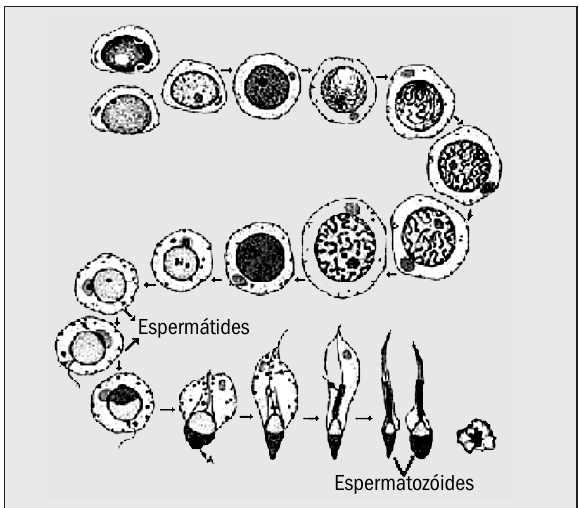
Esperm(cid:135)tides